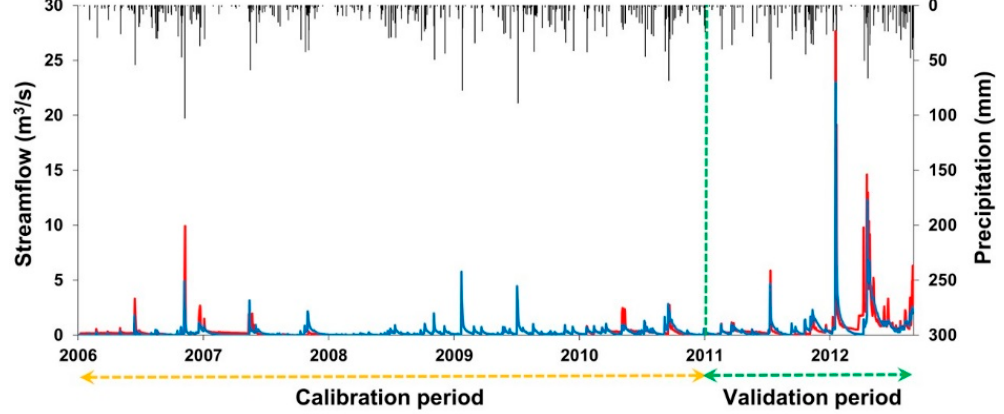
Figure 9. Santa Catalina stream basin daily streamflow and precipitation for the calibration and validation periods. Observed streamflow (red), simulated streamflow (blue), observed precipitation (black).